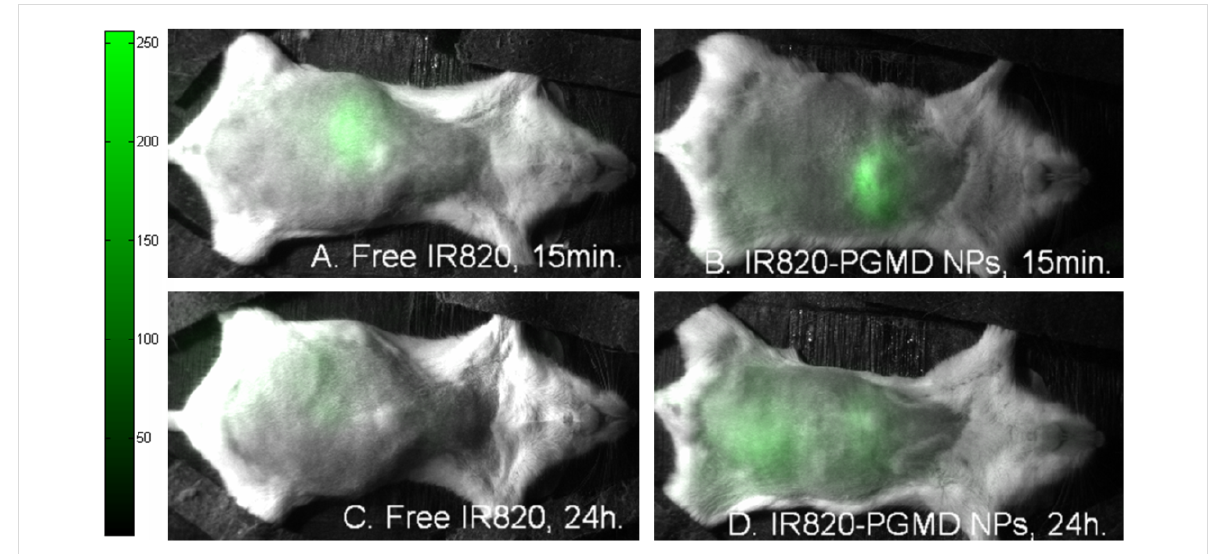
Figure 6: In vivo imaging of free IR820 and IR820-PGMD NPs. Figure 6A and 6B 15 min in vivo imaging. Figure 6C and 6D 24 h in vivo imaging.